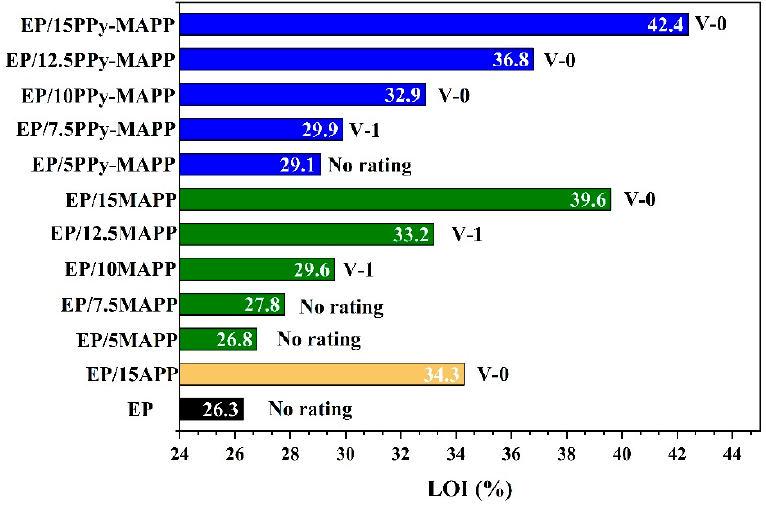
Figure 7. LOI value and UL94 rating of neat EP and EP composites.